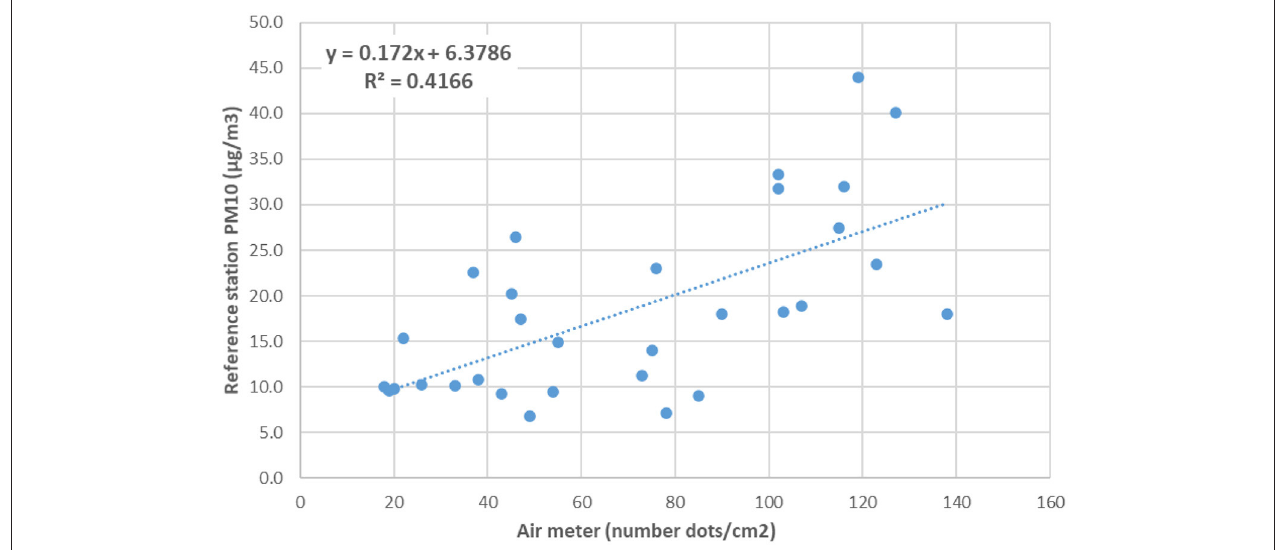
FIGURE 3 | Comparison for the air meter against weekly particulate matter concentrations (PM10) measured at the reference stations of Sofienbergparken (urban background), Kirkeveien (traffic), and Hjørtnes (traffic) in Oslo.